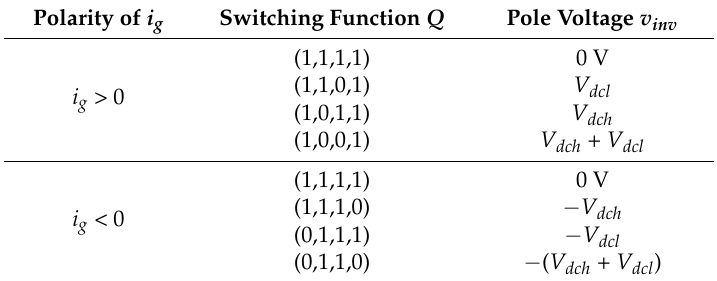
Table 2. The relationship between the switching function and the pole voltage.